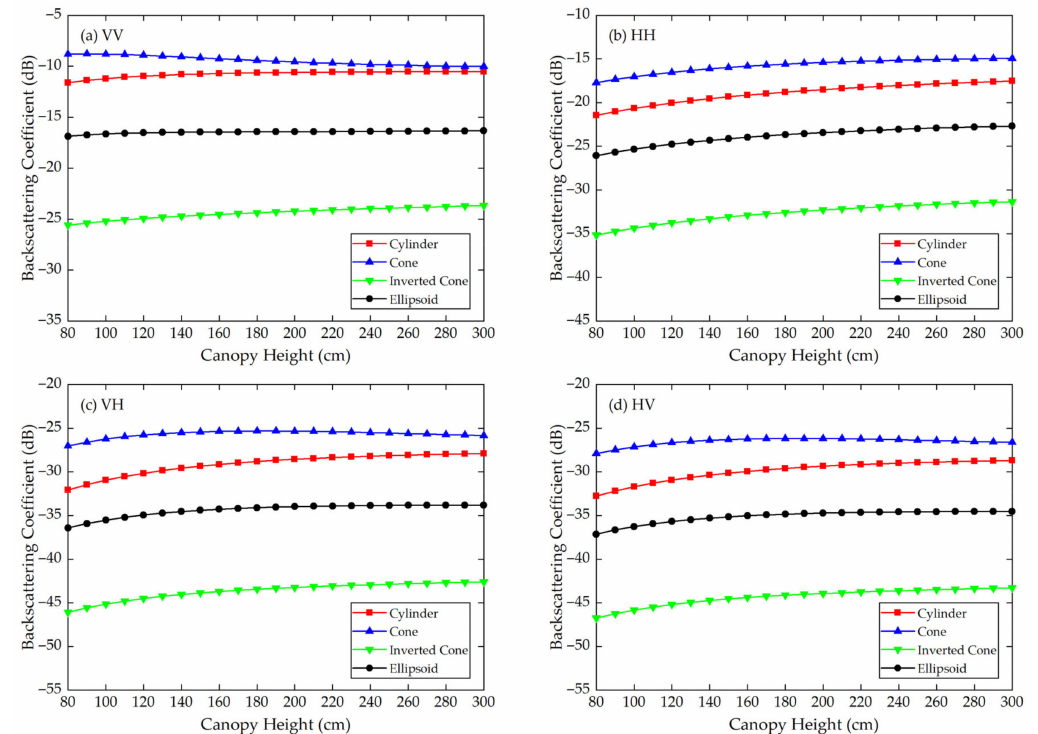
Figure 7. The MTVM simulation results of the backscattering coefficients for different crown shapes in L band (1.2 GHz) at